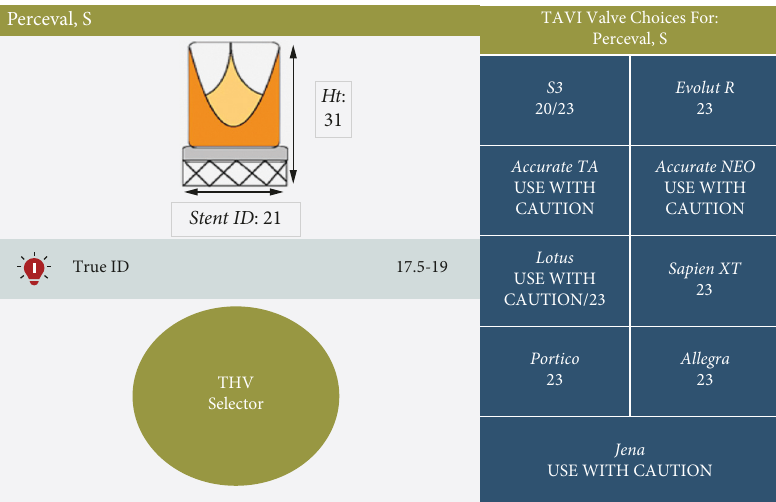
Figure 5: As Inovare ® Alpha is not present in the ViV App, we looked at the Perceval valve, which has a similar true ID. In a true ID of 17.5–19mm, an Evolut R 23mm is suggested.